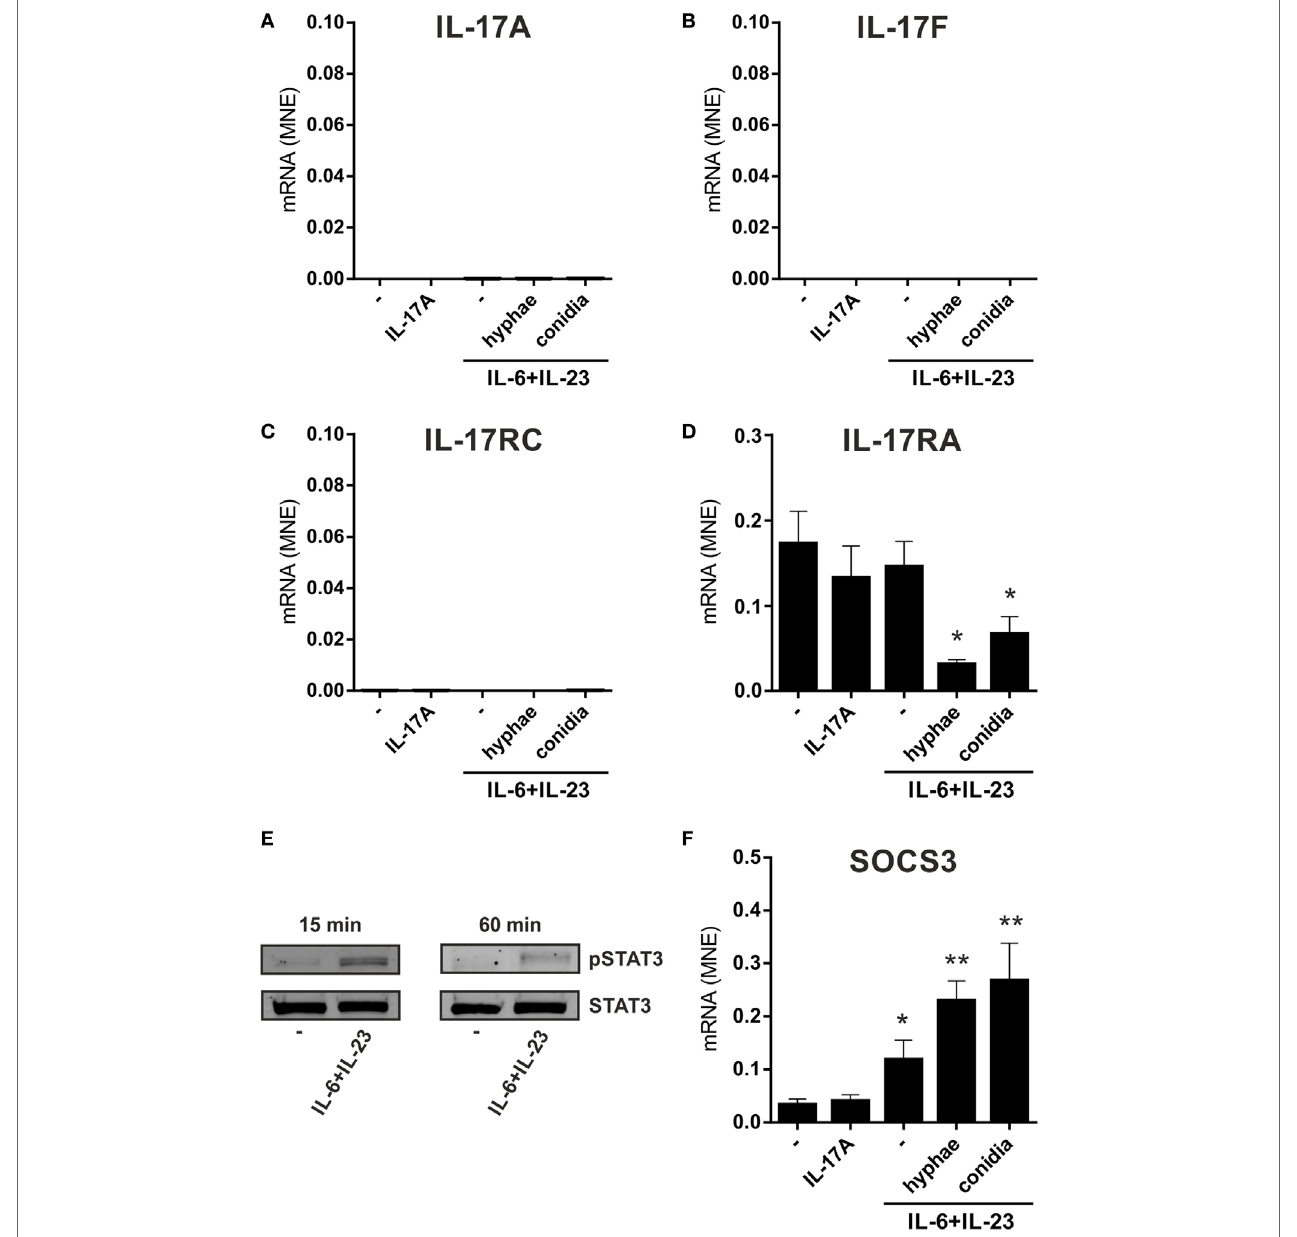
FigUre 2 | No induction of IL-17A, IL-17F, and IL-17RC mRNA expression in neutrophils incubated with IL-6 plus IL-23, in combination with inactivated Aspergillus fumigatus hyphae or conidia. Neutrophils (5 × 10 6 /ml) were incubated either with 100 ng/ml rIL-17A for 2 h or with or without 20 µg/ml IL-6 plus 2 µg/ml IL-23 for 1 h, prior to adding, or not, inactivated A. fumigatus conidia (1:5 neutrophils/conidia ratio) and hyphae (1:1 neutrophils/hyphae ratio) for additional 1 h. Neutrophils were then harvested for RNA extraction to evaluate IL-17A (a) , IL-17F (B) , IL-17RC (c) , IL-17RA (D) , and SOCS3 (F) mRNA expression by reverse transcription quantitative real-time PCR. Gene expression data are depicted as mean normalized expression (MNE) units after GAPDH mRNA normalization (mean ± SEM, n = 4). Asterisks stand for significant differences as compared to untreated cells: * P < 0.05, ** P < 0.01, by Student’s t -test. (e) Immunoblot displaying STAT3 tyrosine phosphorylation in neutrophils, either untreated or cultured for 15 or 60 min with 20 µg/ml IL-6 plus 2 µg/ml IL-23 (representative experiment, n =